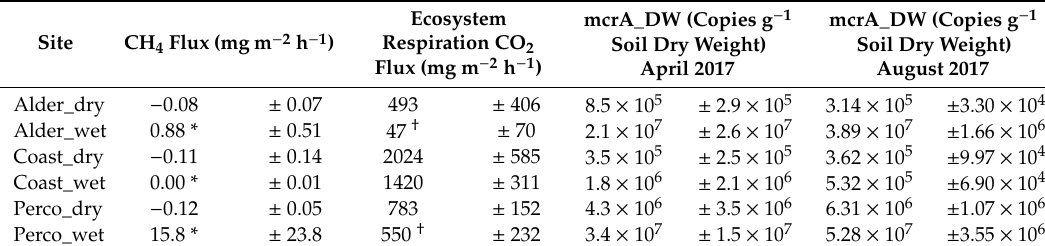
Table 2. Fluxes of CH 4 and ecosystem respiration (measured as CO 2 flux) on all study sites compared to methanogen abundance (mcrA_DW). Negative flux values represent uptake from the atmosphere. Table shows mean values ( n = 5 for CH 4 and ecosystem respiration CO 2 fluxes, n = 9 for mcrA_DW) and standard deviation. Significance was tested with Kruskal–Wallis